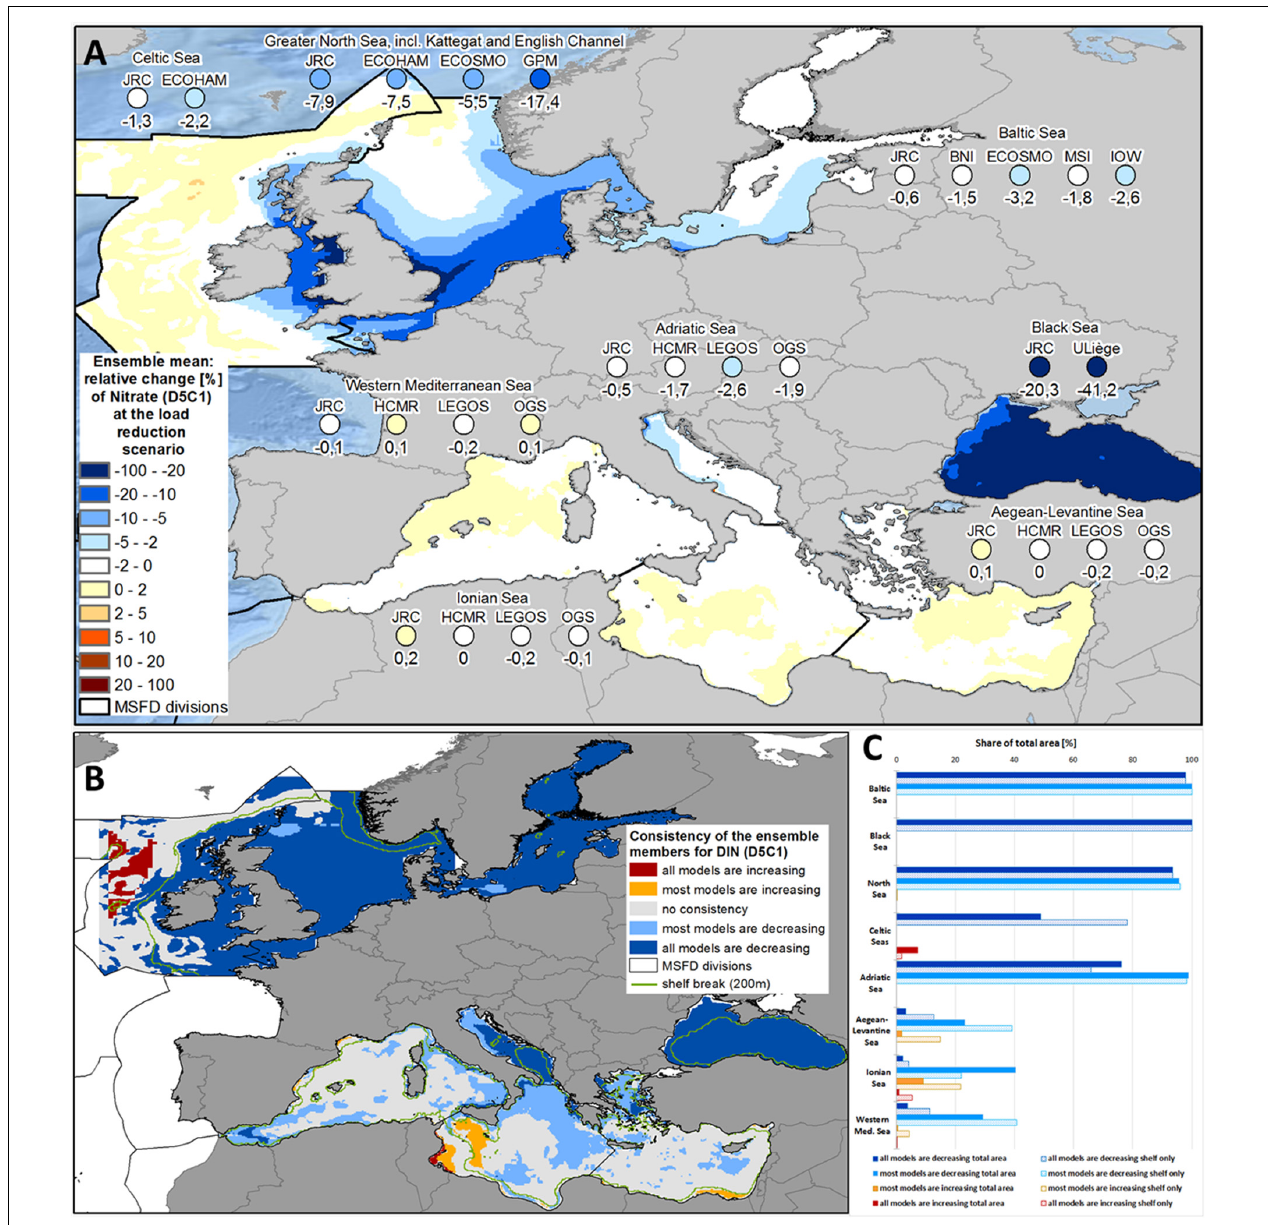
FIGURE 2 | (A) Ensemble means and model-specific relative change at load reduction scenario (compared to reference scenario) for the MSFD regions of nitrate (MSFD indicator D5C1). (B) Consistency map showing, if all or at least most models have the same trend of the relative change at load reduction scenario (compared to reference scenario) with respect to nitrate (MSFD indicator D5C1). (C) Share of the total area (bold bars) and of the shelf region (dotted bar), where all or most models show consistent changes with respect to nitrate (MSFD indicator